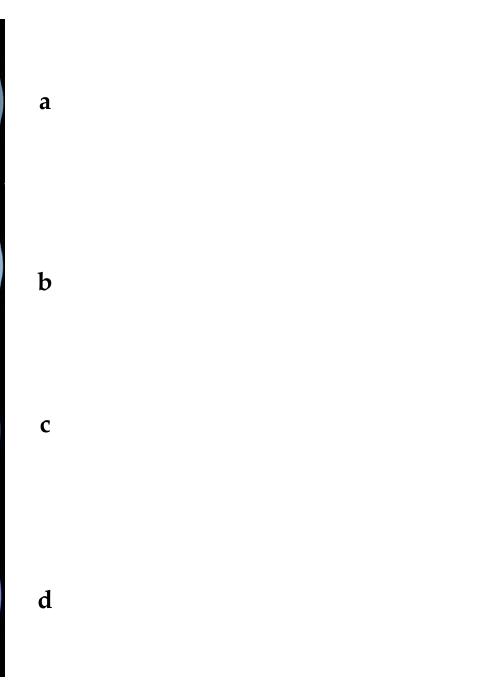
Figure 4. To show the cropped photographs of patients whose nasolabial appearance was unani- mously perceived as ( a ) very good; ( b ) good ( c ) fair; and ( d ) poor, according to the scoring system used [19,21,22].